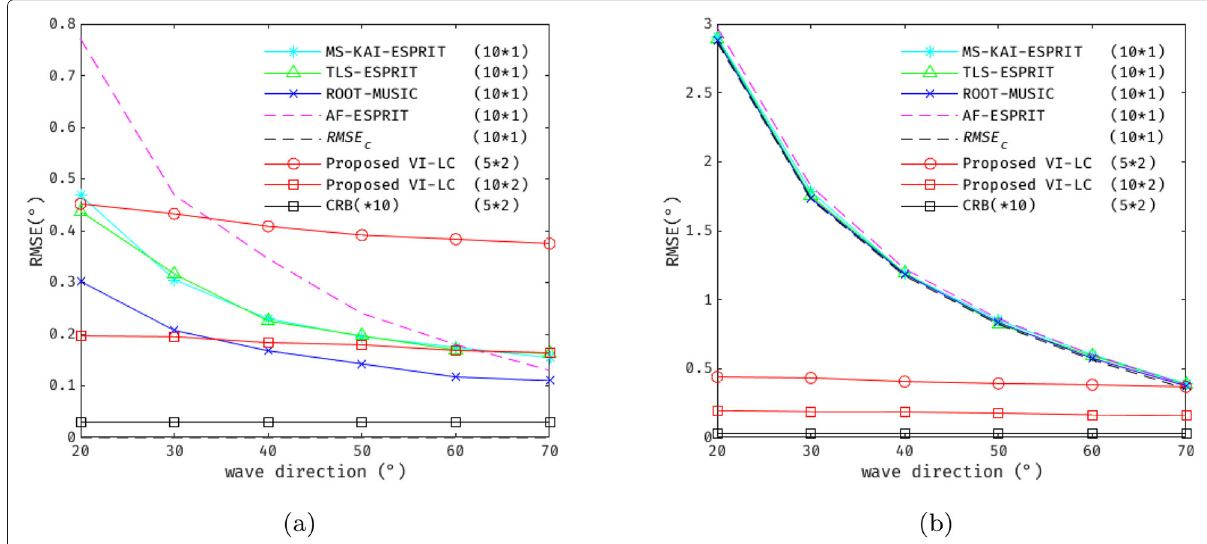
Fig. 5 RMSE versus wave directions. a (cid:8) c = 0 m/s and b (cid:8) c = − 25